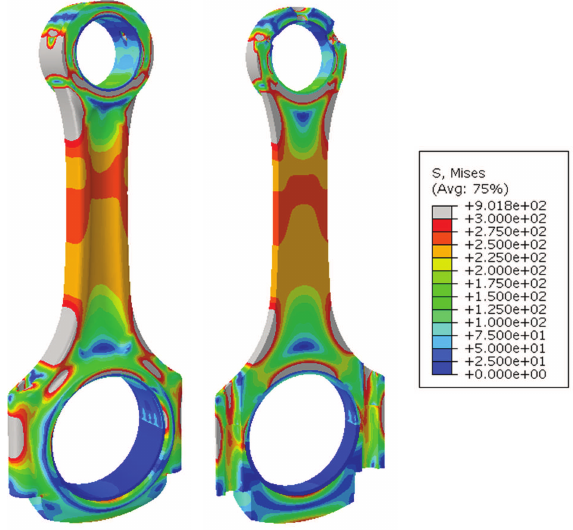
Fig. 6. Results of simulation tests, connecting rod compression 2 version